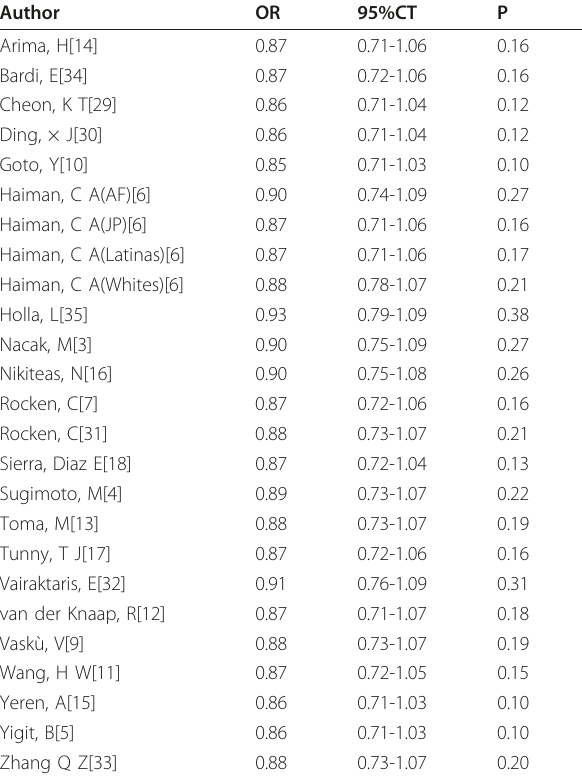
Table 4 Sensitivity analysis for the current meta-analysis: ORs with 95%CIs and P value were results after excluding each case-control study for DD+DI